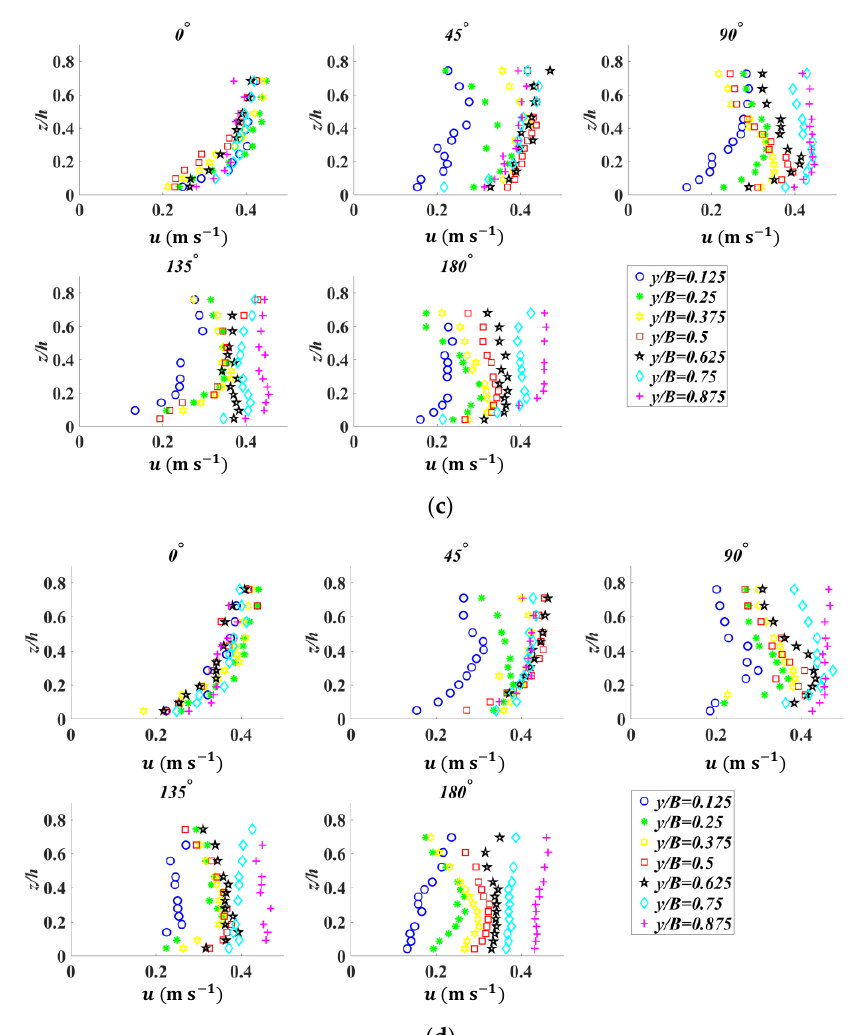
Figure 3. Longitudinal velocity profiles for four cases at five cross sections: ( a ) Bare case, ( b ) Small case, ( c ) Middle case, and ( d ) Big case ( Q = 0.030 m 3 s −1 ) .